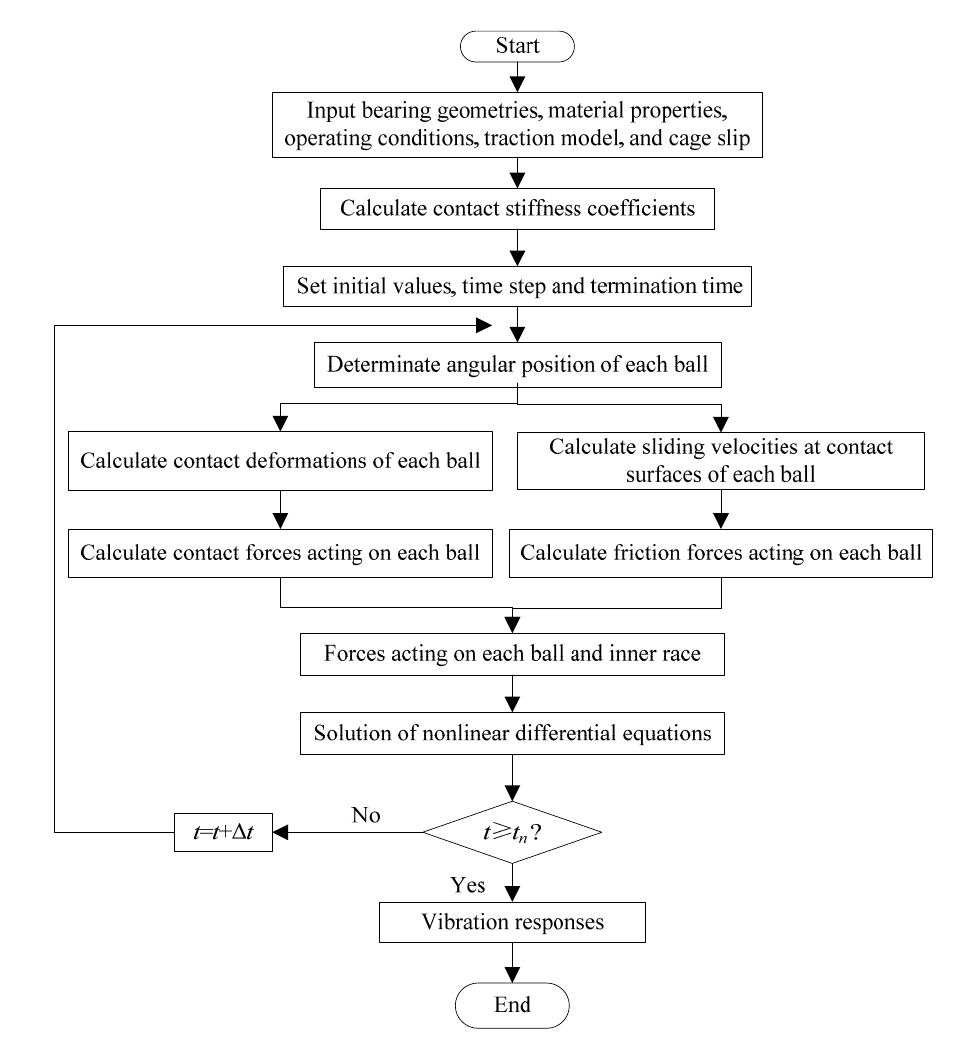
Figure 6. Flowchart of the solution process. Table 1. Values of some parameters for the deep groove ball bearing.